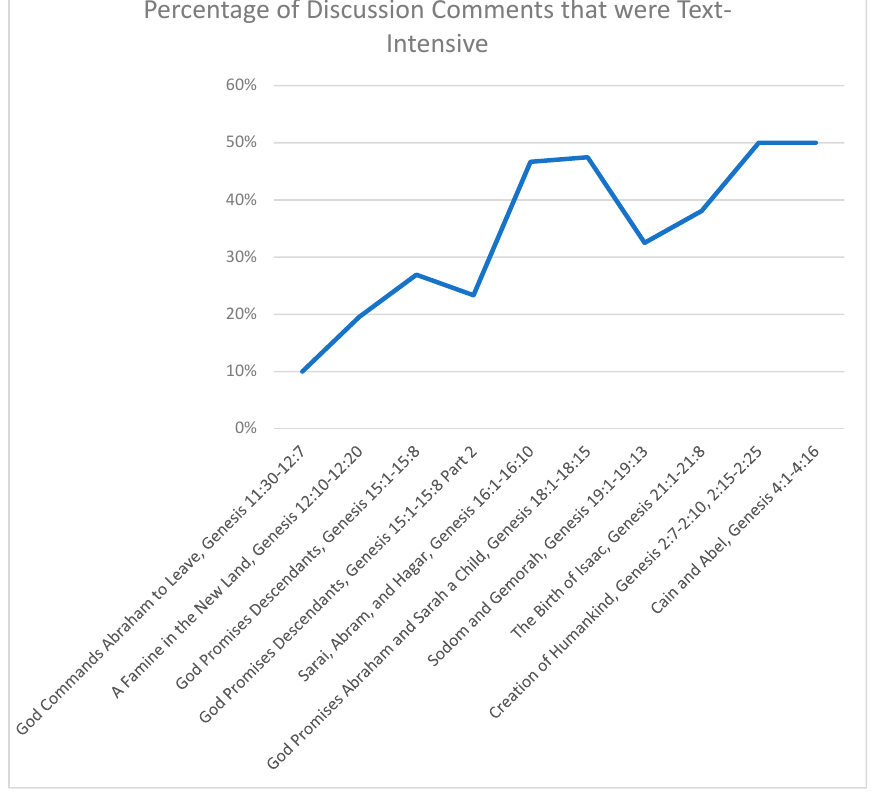
Figure 1. Growth in text-intensive comments during whole class text discussion.